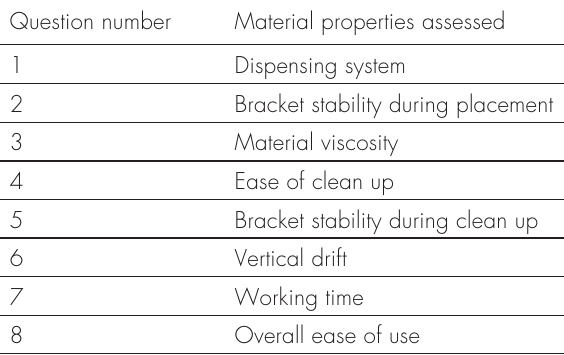
Table II. Material properties rated by participants. The property ‘vertical drift’ refers to the ease of product handling relative to undesirable movement of the bracket along the long axis of the tooth during bracket positioning.